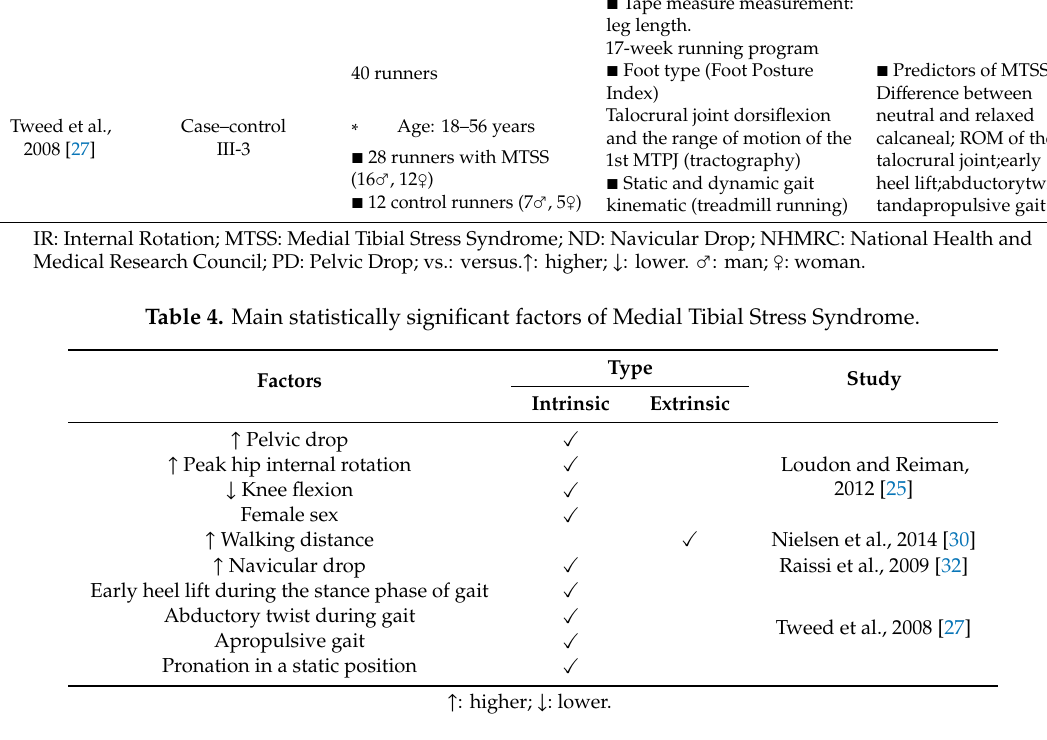
Table 5. Summary of studies analyzing diagnostic